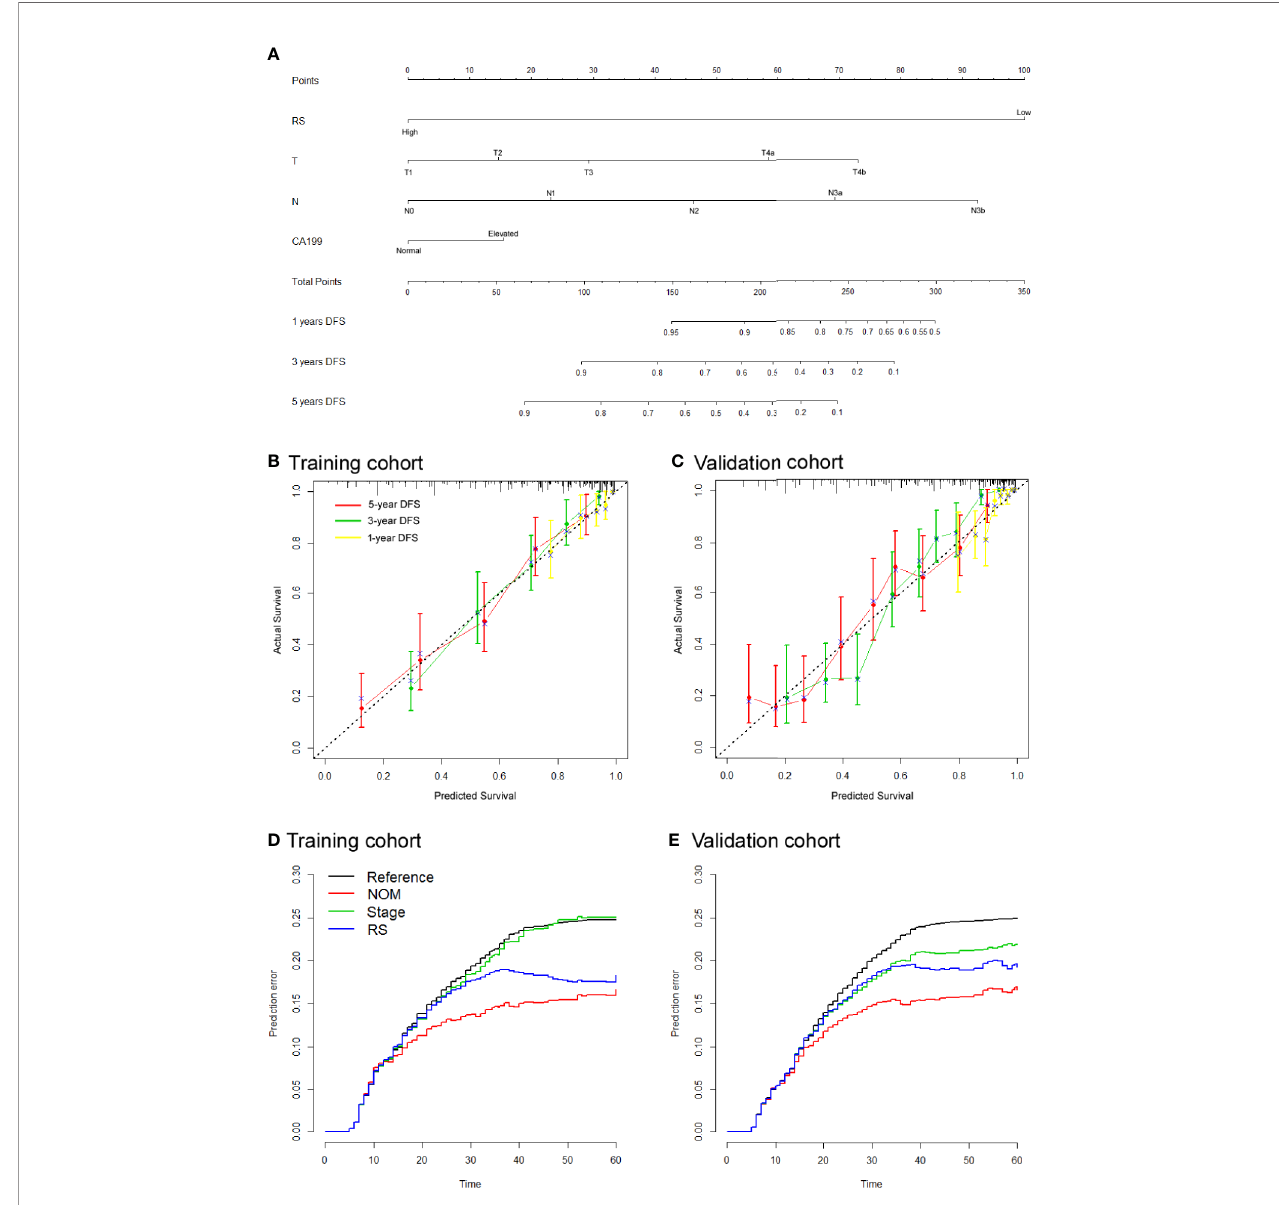
FIGURE 3 | Use of the constructed radiomics nomogram to estimate disease-free survival (DFS) for gastric cancer (GC), along with the calibration and prediction error curves (A) . Radiomics nomogram to estimate DFS. Calibration curves for the radiomics nomogram of DFS in the training cohort (B) and validation cohort (C) show the calibration of each model in terms of the agreement between the estimated and the observed 1-, 3-, and 5-year survival outcomes. The nomogram- estimated DFS is plotted on the x-axis, and the observed DFS is plotted on the y-axis. The diagonal dotted line is a perfect estimation by an ideal model, in which the estimated outcome perfectly corresponds to the actual DFS. The solid line is the performance of the nomogram: a closer alignment with the diagonal dotted line represents a better estimation (D, E) . Prediction error curves for each model. Lower prediction errors indicate higher model